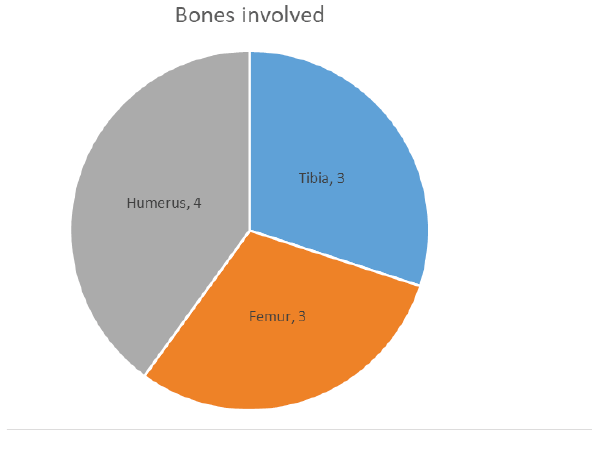
Figure 2. Age distribution of patients Among the 10 fractures, there were four humeri, three tibiae, and three femora in the study (Figure 3).